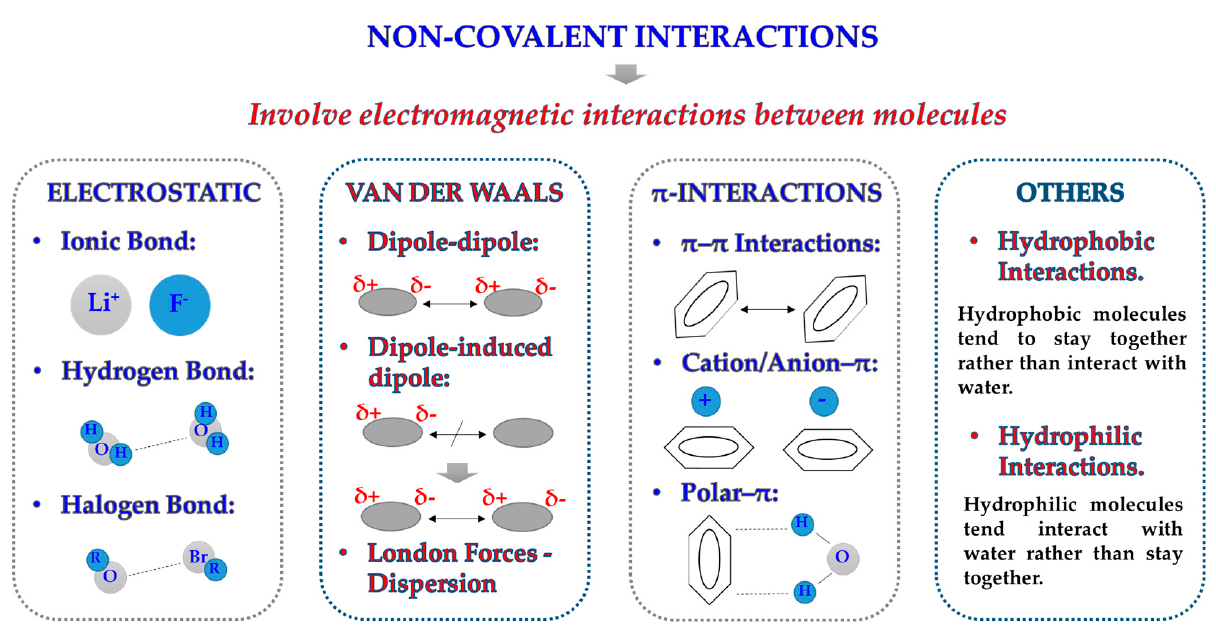
Figure 2. Schematic illustration of the different types of non-covalent interactions that could participate in the protein adsorption process.